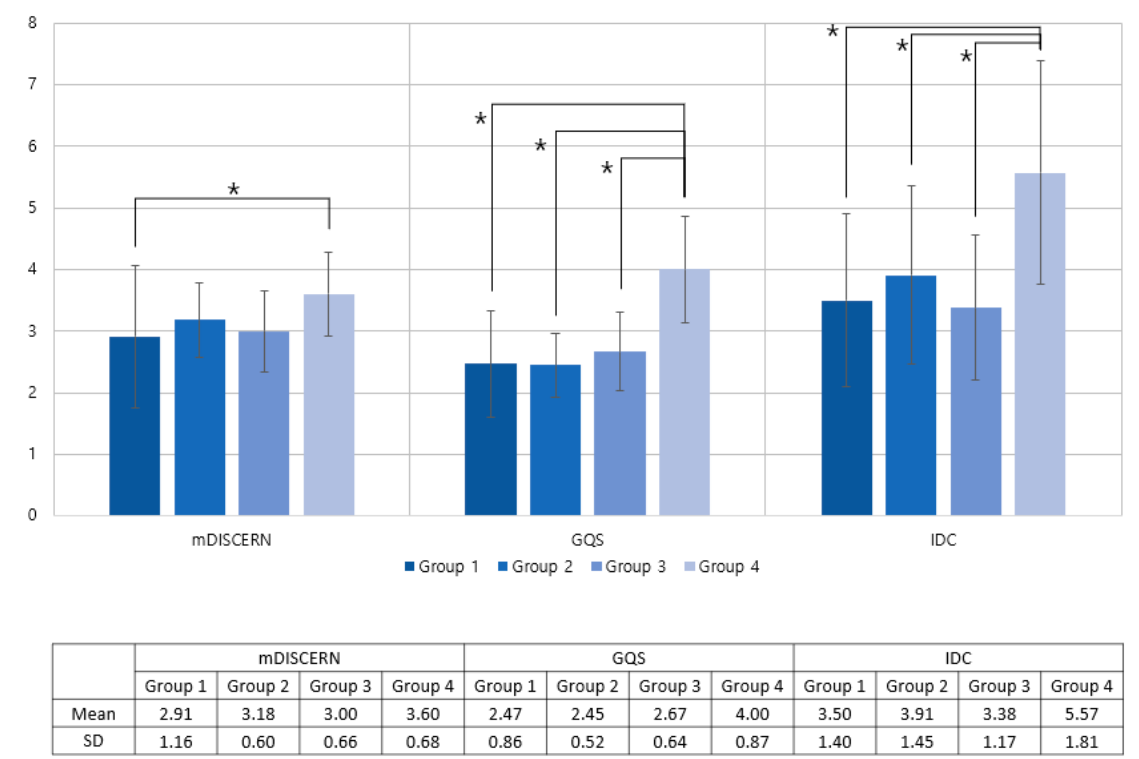
Figure 4. Distribution of mDISCERN, GQS, and IDC as a group by the expertise of lecturer and